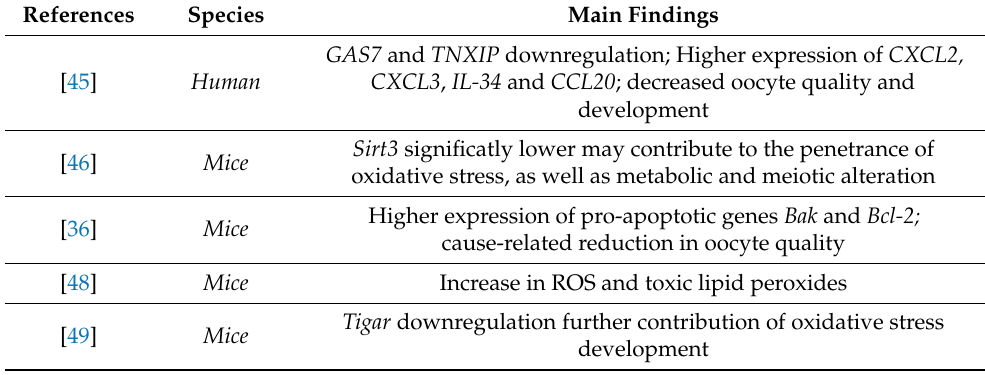
Table 5. Summary of the main findings related to the impacts of a high-fat diet on inflammation and oxidative stress pathways in